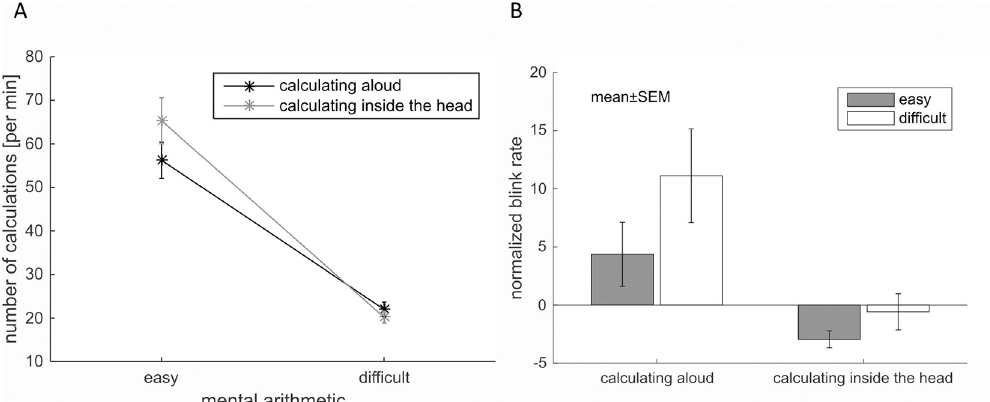
Fig 5. Results of cognitive tasks. A. Performance assessment during cognitive tasks. B. Influence of cognitive task demands on the blink rate. Blink rate during “baseline 1” was subtracted from the blink rate in each task showing that only the blink rate in the “calculating aloud–difficult” task was strongly increased. Only the main effect of “calculating aloud” vs “calculating inside the head” was significant ( p < .004).